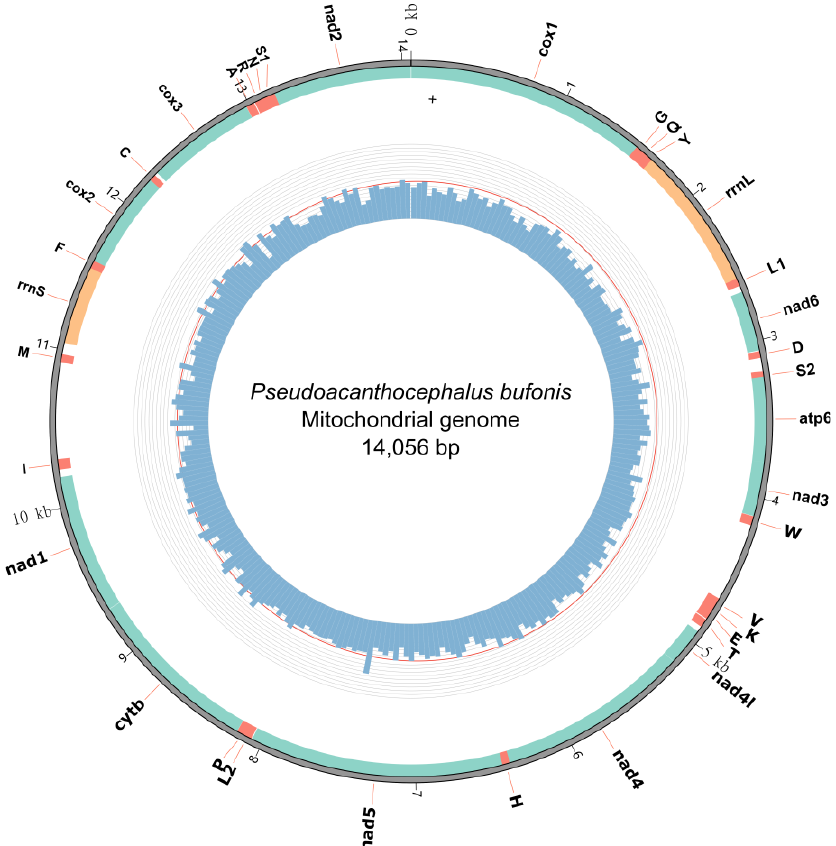
Figure 2. Gene map of the mitochondrial genome of Pseudoacanthocephalus bufonis . The outermost circle shows the gene features, sandy brown for rRNAs, salmon for tRNAs, and light sea green for PCGs. The innermost circle shows the GC content calculated in every 50-site window.